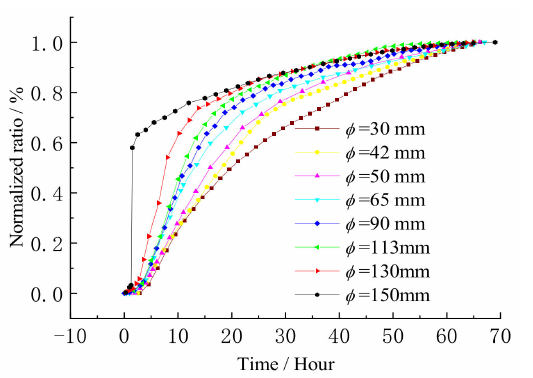
Figure 4. Time histories of amplitude coefficient for radial pressure and temperature for SCA in steel cylinders with varying